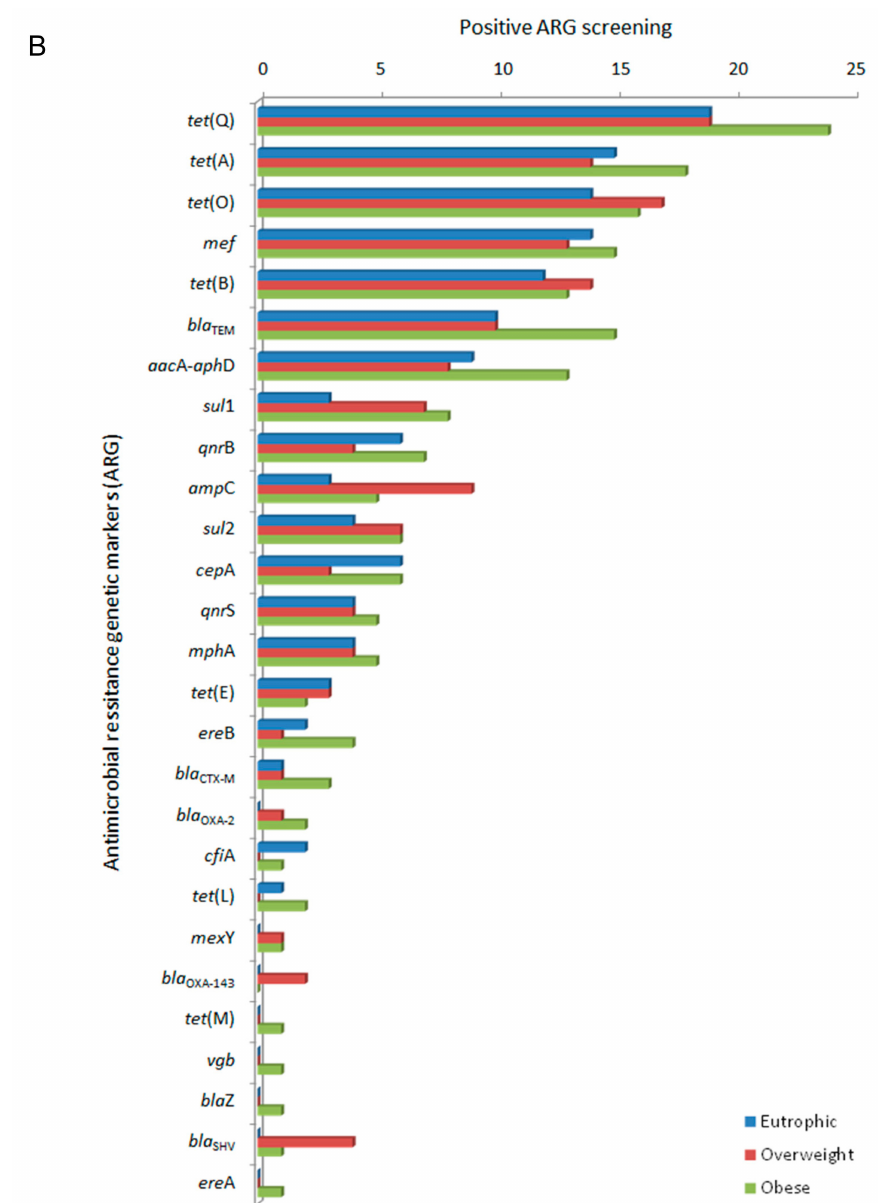
Figure 1. Distribution of antimicrobial resistance genetic markers (ARG) related to different classes of antimicrobial drugs accordingly to positive screening by PCR of the faecal metagenome from eutrophic, overweight, and obese individuals. ( A ) ARG were clustered based on their chemical structure or phenotype, such as β -lactams, tetracyclines, macrolide lincosamide and streptogramin group (MLS), quinolones, sulfonamides and aminoglycosides, and efflux pumps. For the obese, overweight and eutrophic groups, ARG screening was positive in 176, 145 and 132 tests, respectively. Captions a , b , and * indicate statistically significance ( p < 0.05). ( B ) Absolute distribution (number of positive screenings) of 27 positive ARG out of 55 tested genetic markers in intestinal metagenomes from eutrophic, overweight and obese individuals. β -lactams( amp C, bla CTX-M , bla TEM , bla SHV , bla OXA-2 , bla OXA-143 , cfi A, cep A, bla Z, mef );tetracyclines ( tet (A), tet (B), tet (E), tet (L), tet (M), tet (O), tet (Q)); macrolides, lincosamide and streptogramin group (MLS) ( mph A, ere A, ere B, vgb ); quinolones ( qnr B, qnr S); sulfonamides ( sul 1, sul 2); aminoglycosides ( aacA-aphD ); and efflux pumps ( mex